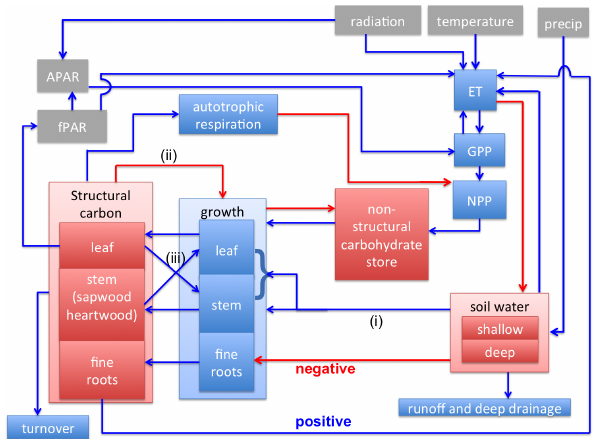
Figure 1. Schematic showing the key elements of HAVANA, and the qualitative relationships between them. Carbon and water pools are represented by red boxes and fluxes by blue boxes. Blue (red) arrows show positive (negative) feedbacks. Less intuitive feedbacks are as follows. (i) Soil water influence on growth: soil water pos- itively impacts on total growth, while there is a negative feedback of soil moisture on allocation to fine roots, in favour of the com- bined (leaf + stem) compartment; (ii) growth responds negatively to the structural carbon store as it approaches carbon carrying ca- pacity Eq (1.0); and (iii) partitioning of growth between leaf and stem is influenced by the relative magnitudes of leaf and sapwood compartments, which are constrained by the pipe model (Shinozaki et al., 1964), in which sapwood cross-sectional area is assumed to be a constant proportion of total leaf